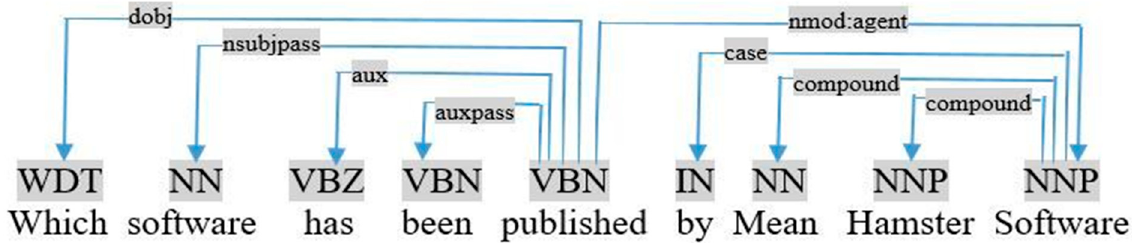
Figure 6. Graph dependency of the query «what is the profession of Frank Herbert».